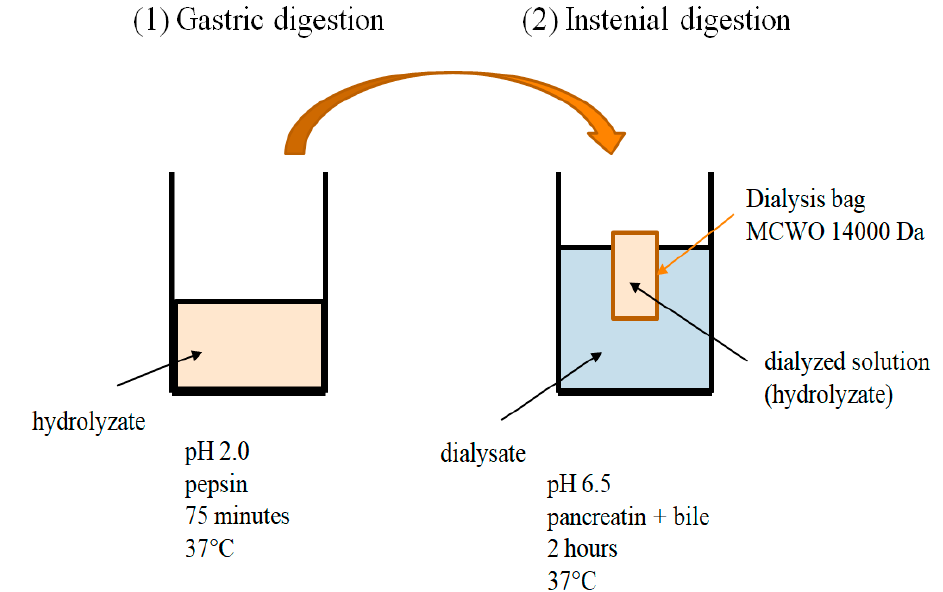
Figure 2. Scheme of in vitro digestion: ( 1 ) gastric digestion: enzyme: pepsin, pH: 2.0, digestion time: 75 minutes at 37 °C; ( 2 ) intestinal digestion: enzymes: pancreatin and bile, pH: 6.5, digestive time: 2 hours in 37 °C